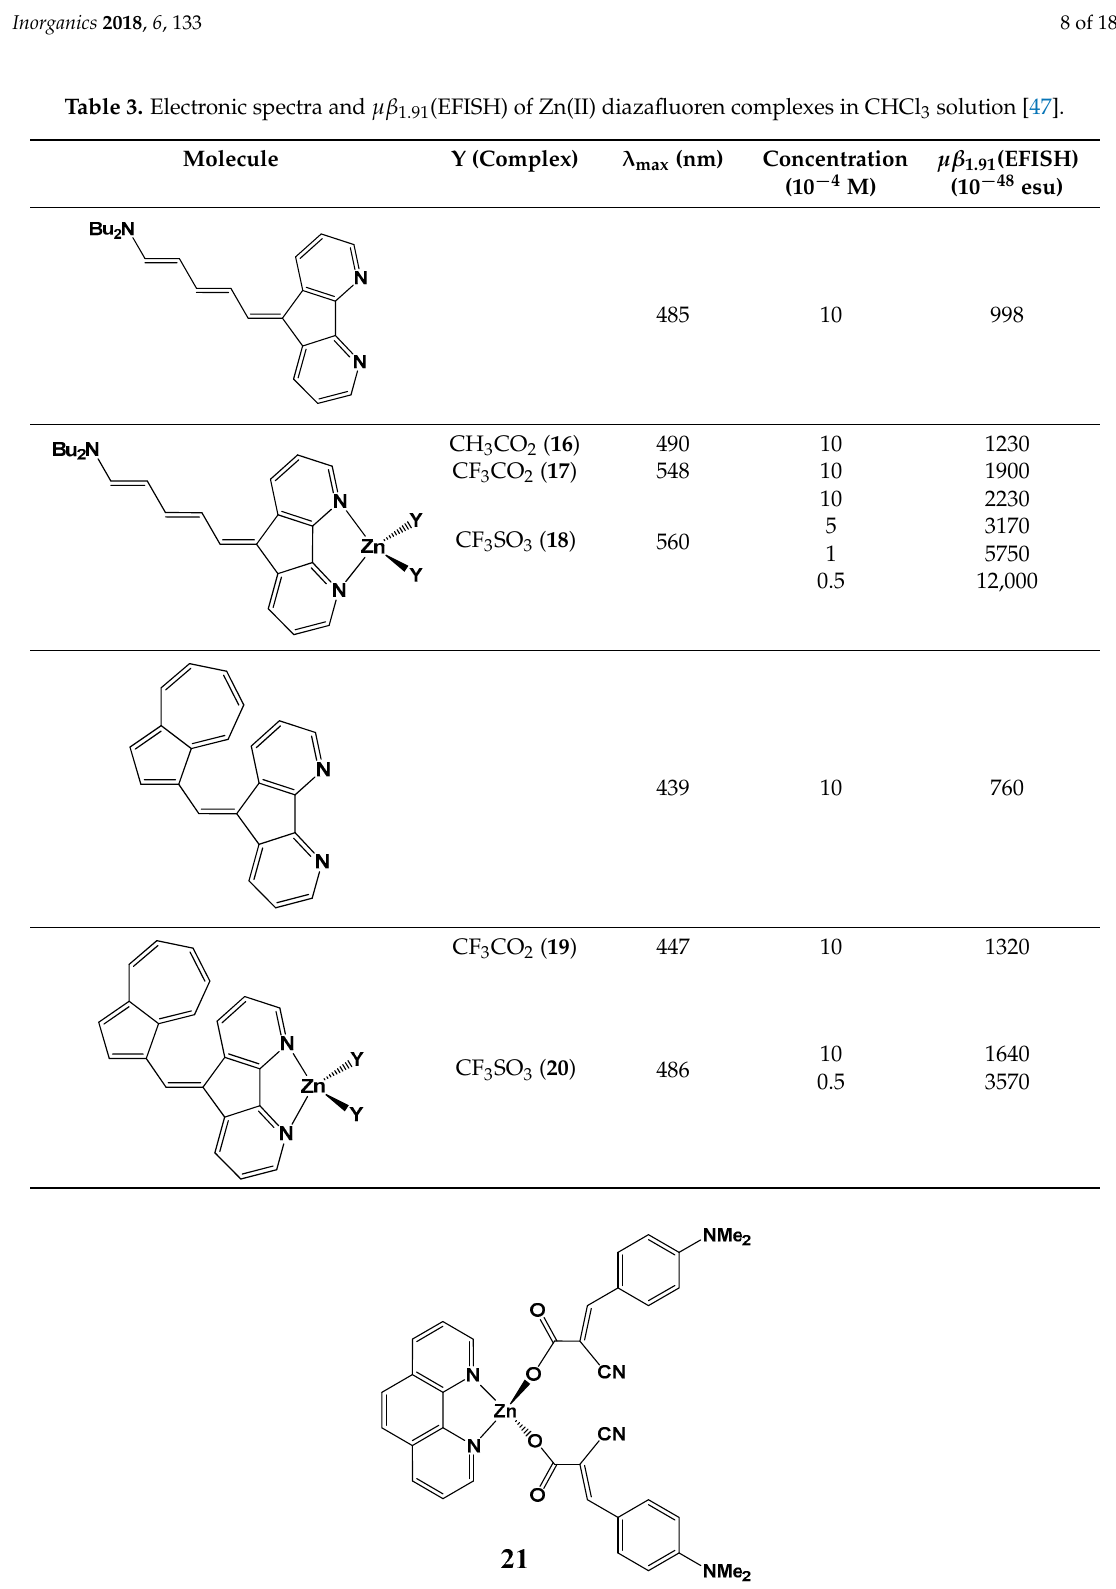
Figure 3. Zn(II) phenanthroline complex bearing a push–pull carboxylate ligand.